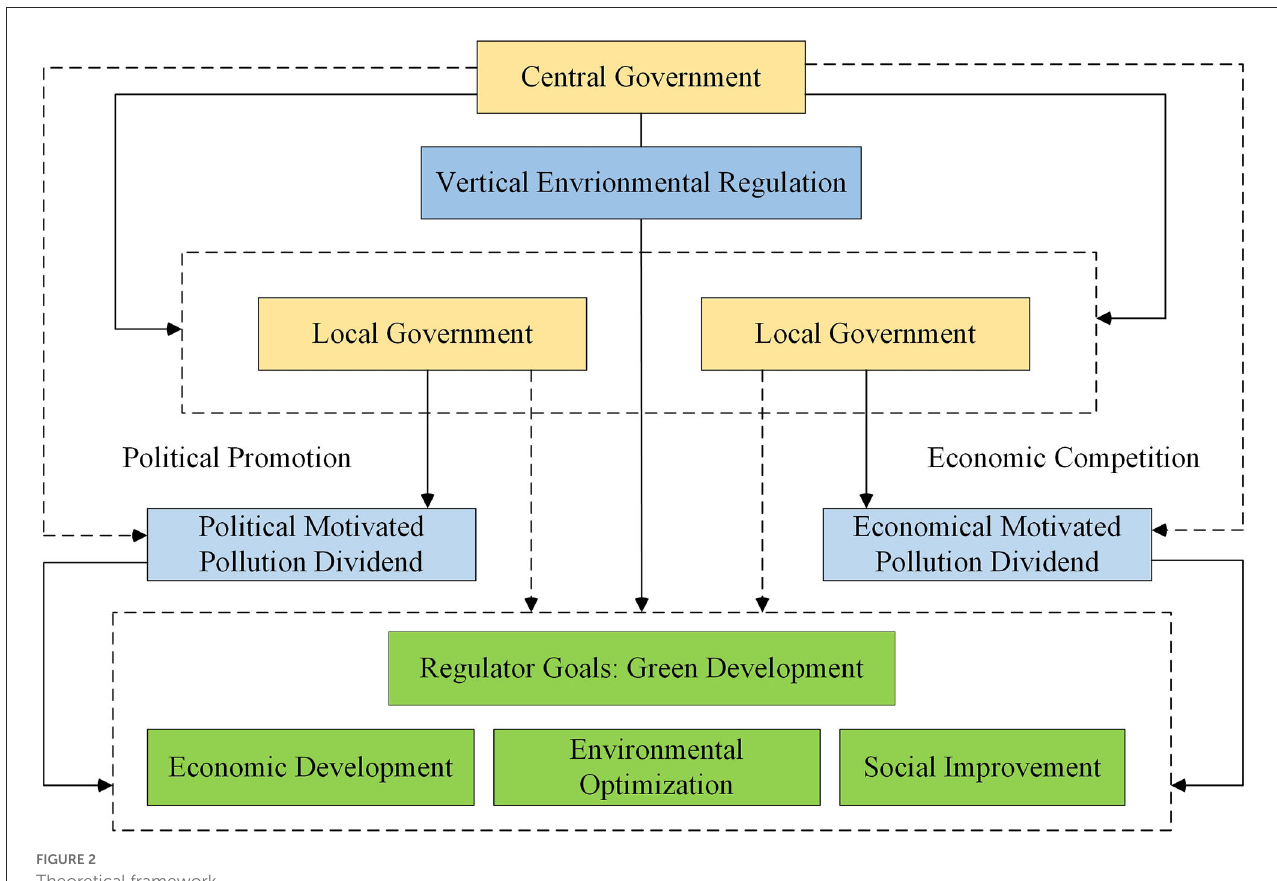
FIGURE2 Theoretical